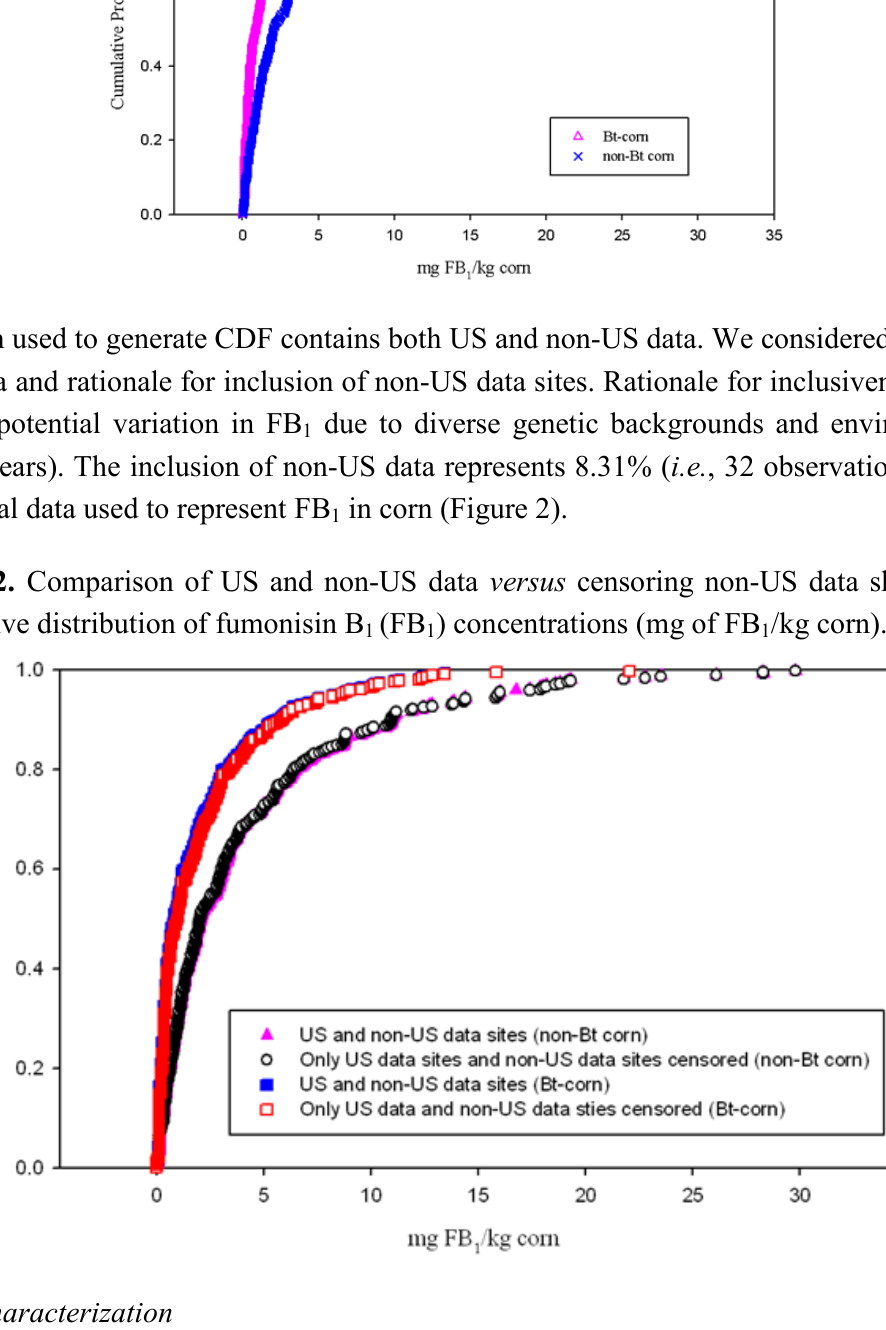
(FB ) concentrations (mg of FB 1 1